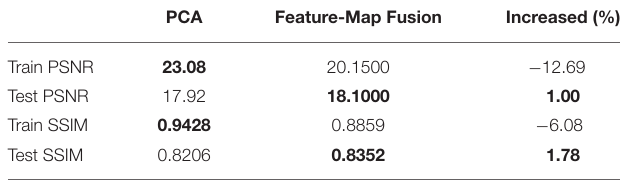
TABLE 1 | Core parameters of FrScatNet with and without feature dimensionality reduction. Parameter